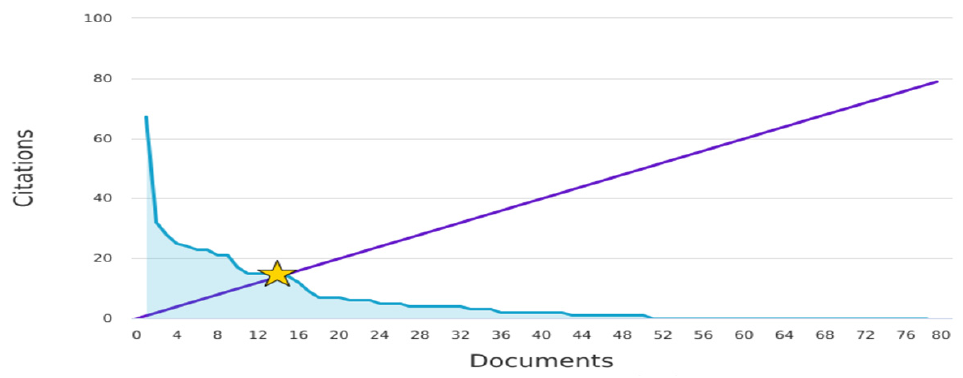
Figure 2. Documents h-index graph showing an h-index of 14.